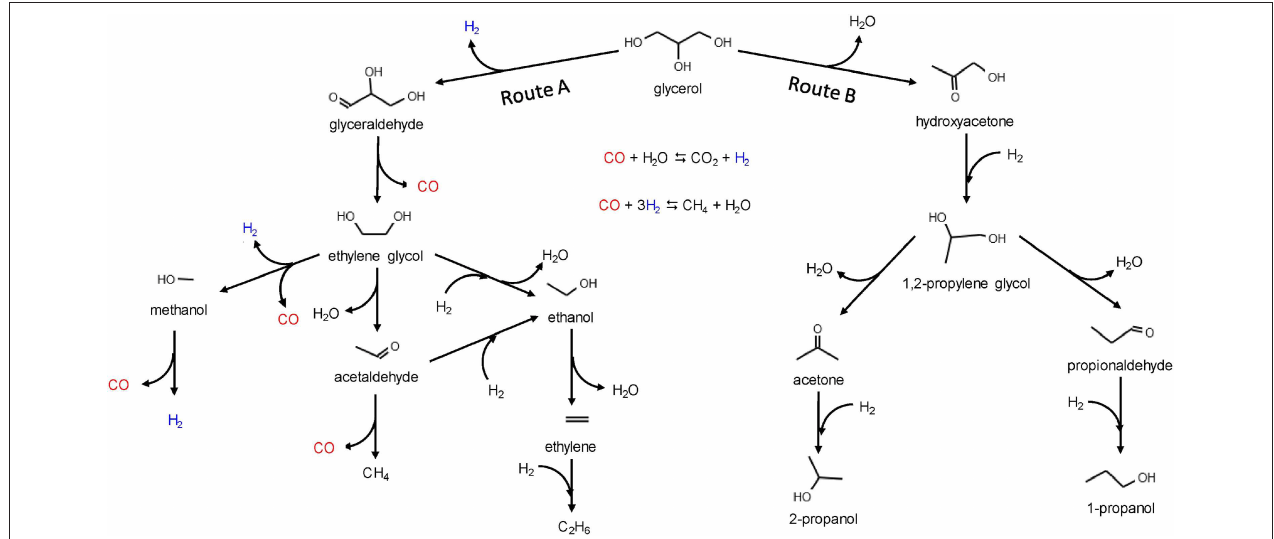
FIGURE 9 | Reaction network for the glycerol APR on nickel catalysts. Reprinted from Morales-Marin et al. (2019), with permission from Elsevier.